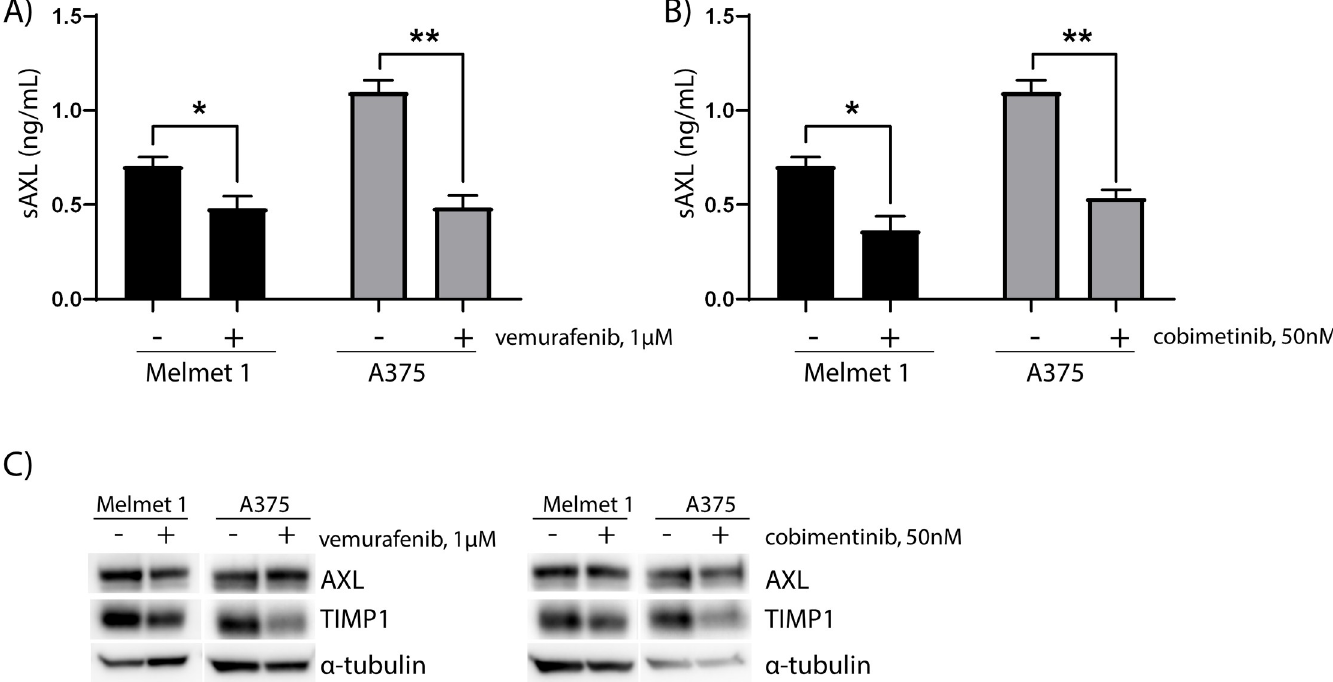
Fig 3. MAPKi results in reduced sAXL without affecting AXL expression. sAXL levels in the media of Melmet 1 and A375 cells treated with A) 1 μ M vemurafenib and B) 50nM cobimetinib and C) AXL and TIMP1 cellular levels in the corresponding cell lines as visualized by representative immunoblots. Cells were treated with the inhibitors for 24 hours before media or cells were harvested. sAXL levels were determined by ELISA and show average sAXL levels + SEM of three independent experiments. For A and B, the control cells are the same as in Fig 2B. α -tubulin was used as loading control for the immunoblot. � = p value � 0.05 and �� = p value � 0.01 calculated using student two-tailed